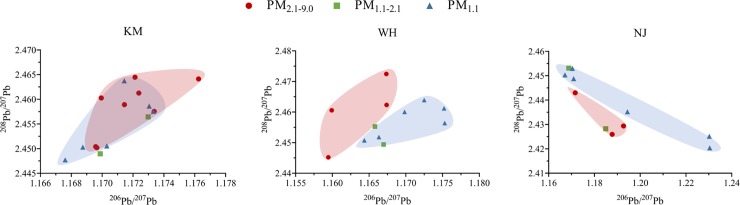
Lead isotopic compositions (206Pb/207Pb, 208Pb/207Pb) for different atmospheric fractions of PM2.1–9.0, PM1.1–2.1 and PM1.1 at sampling sites of KM, WH and NJ.